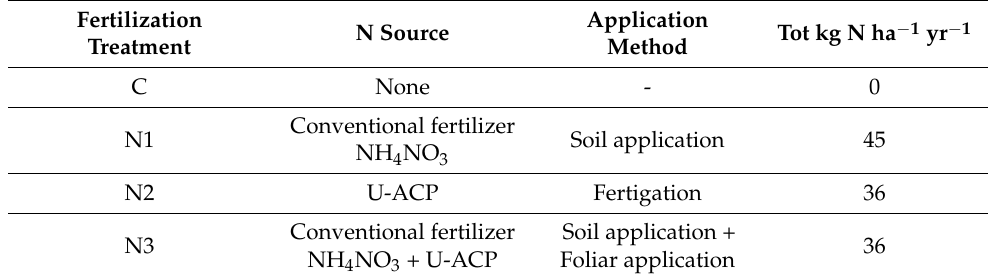
Figure 1. Location of the experimental site at the Research Centre for Viticulture and Oenology in Conegliano, Veneto Region, Italy. Table 1. Summary table of the fertilization treatments applied in the trial, with indication of the N source, the application method and the total amount of N applied per year.